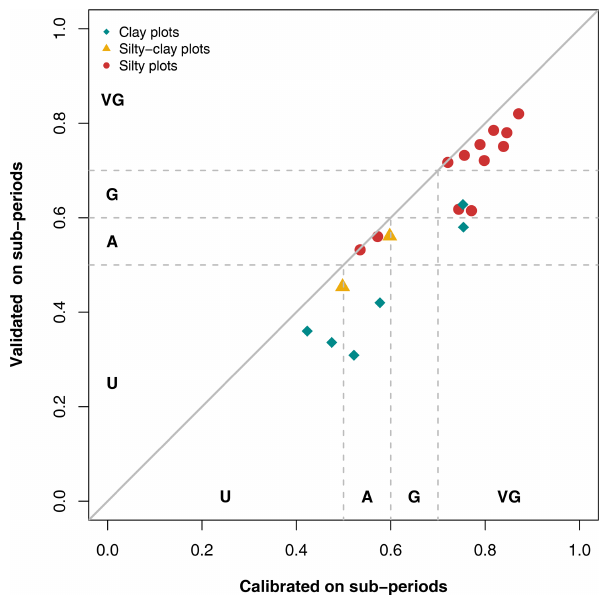
Figure 8. Comparison between the KGE (cid:48) values assessed over the calibration and evaluation periods on the nine plots used for the split-sample test, where U is unsatisfactory, A is acceptable, G is good, and VG is very